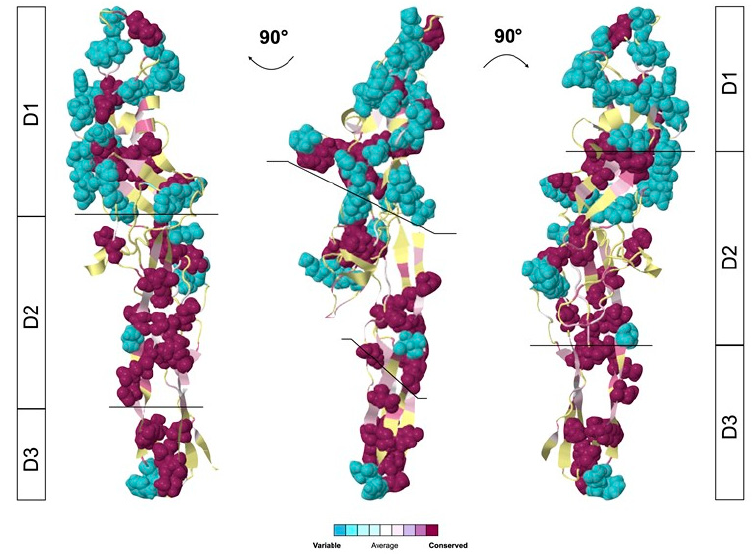
Figure 5. ConSurf distribution of conserved amino acids in predicted Glabralysin protein structures. Sequence conservation is plotted on the surface of the predicted structure of Gla2Aa1. Residues are colored according to the conservation, from red representing identity to cyan representing no conservation. Low reliability positions are marked yellow in the 3D structure. Different views of the same structural alignments were shown rotated by 90°.